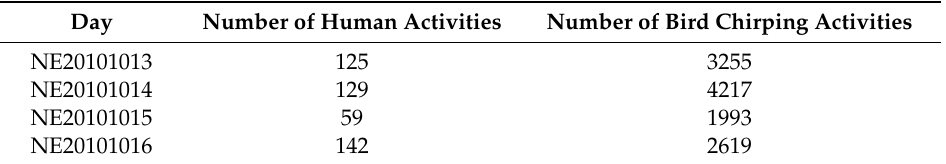
Table 1. Di ff erent activities in the